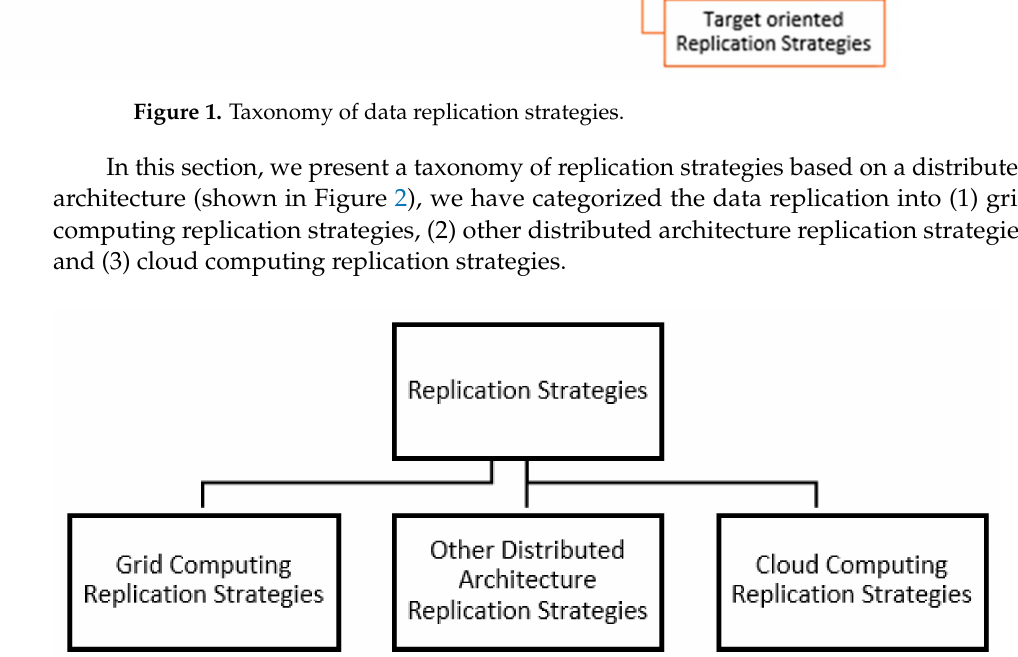
Figure 2. Demonstrates the classification of replication strategies based on a distributed